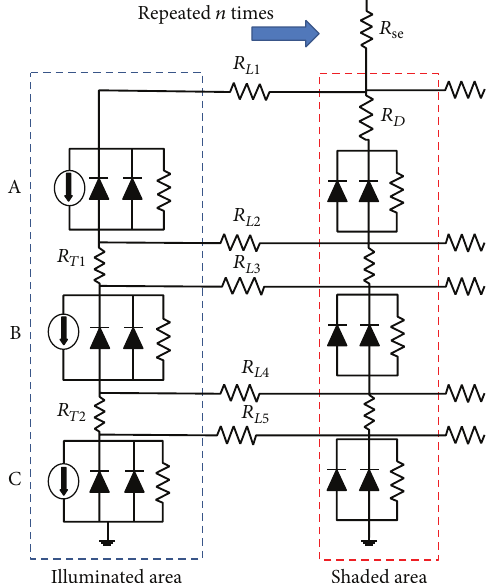
Figure 3: 2-D distributed resistance model developed in SPICE showing the two-diode equivalent circuits for each of the subcells where (A) top subcell, (B) middle subcell, and (C) bottom subcell are connected in series using tunnel junctions. An illuminated and a shaded unit form a complete functional block that is repeated 𝑛